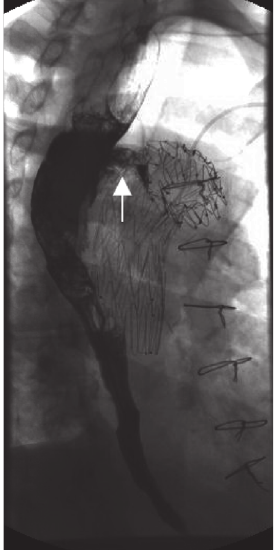
Figure 3: Upper gastrointestinal study with barium contrast show- ing extraluminal contrast seen arising from proximal esophagus extending outward visualizing the fistulous